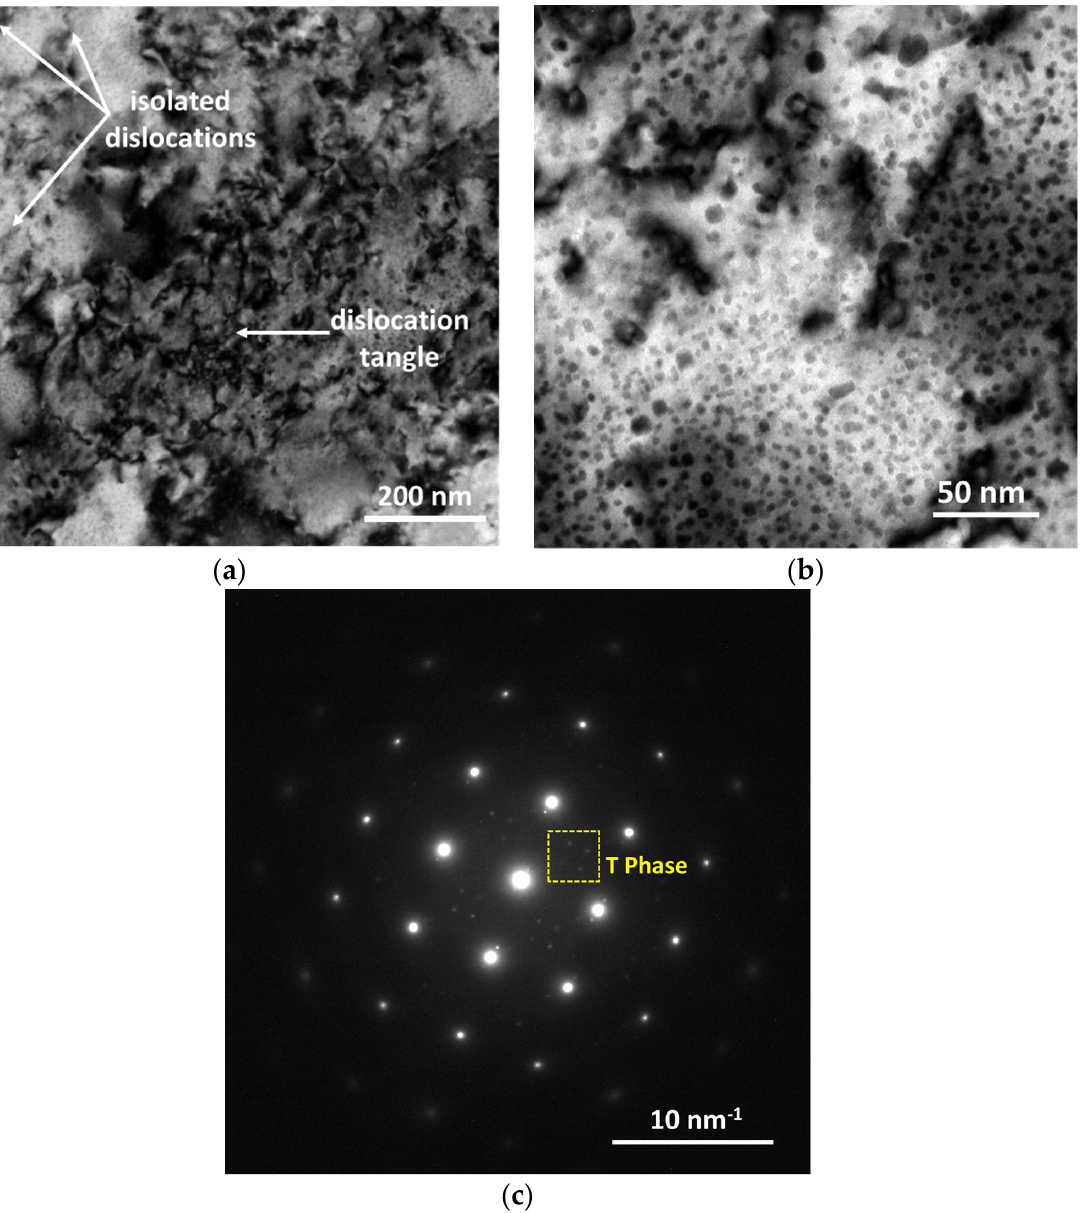
Figure 7. TEM images showing the typical microstructure of FTMT–9–12–a sample: ( a ) BF image showing the dislocation distribution; ( b ) BF image showing the precipitates; and ( c ) SAED pattern corresponding to ( b ).